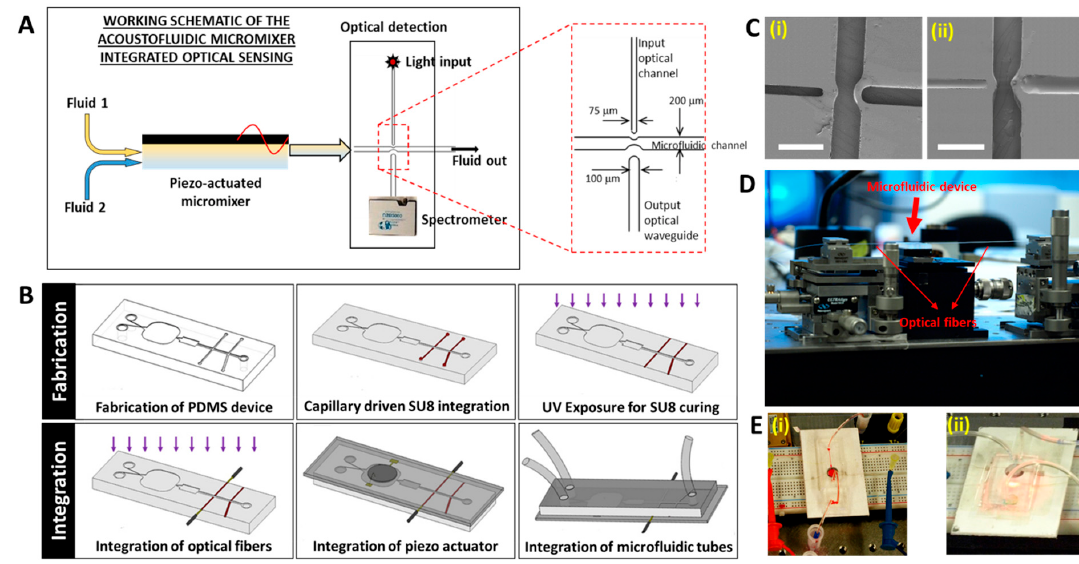
Figure 2. ( A ) Schematic working principle of the acoustofluidic micromixer integrated optical sensing for colorimetric detections. The liquid test specimen (fluid 1) and its corresponding chromogenic agent (fluid 2) are mixed using acoustic waves generated by a piezoacuator, and the mixture is transported into the optical detection unit, wherein the extent of color change induced due to the presence of target analyte in the sample is sensed by the absorption of light passing through the sample. ( B ) Schematic illustrayion of the fabrication and packaging of the hybrid integrated biosensor ( C ) Scanning electron microscope (SEM) images showing the microfluidic channel and the optical channels of the poly dimethylsiloxane (PDMS) device (i) before and (ii) after integration with SU8 (Scale bars represent 500 m) ( D ) Micro-positioning setup for precise alignment and coupling of fibers with the SU8 waveguides. ( E ) Images of the functional integrated optical microfluidic biosensor (i) with one fluid inlet and (ii) two fluid inlets.